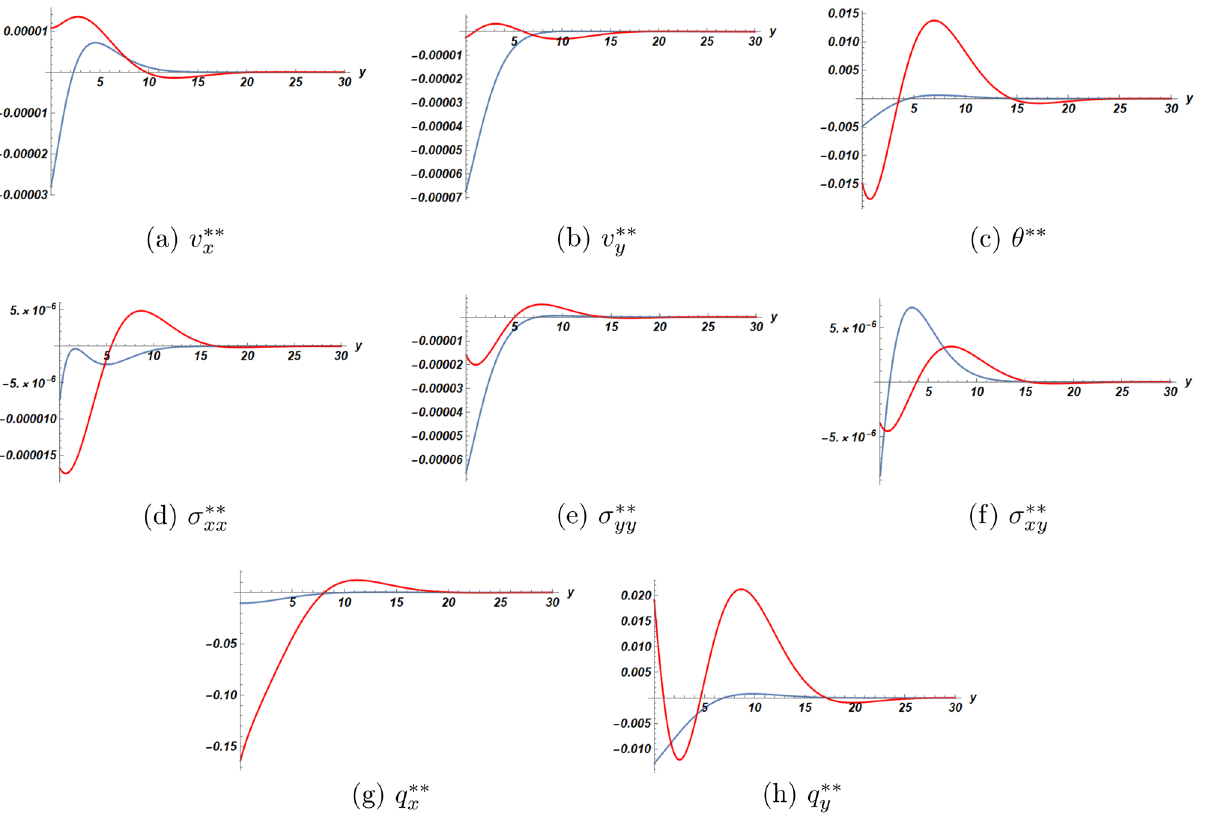
Figure 5. Comparison of second order solutions as functions of y at x = 2 , t = 2.1 (red dot) half-space (blue dot) half-space with